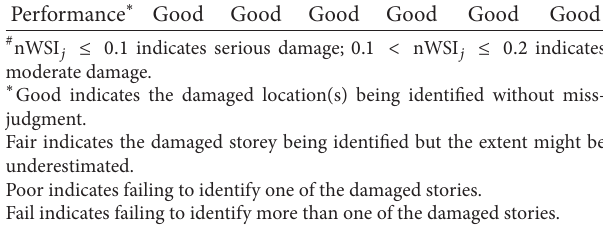
Figure 4: The benchmark model for experimental verification.